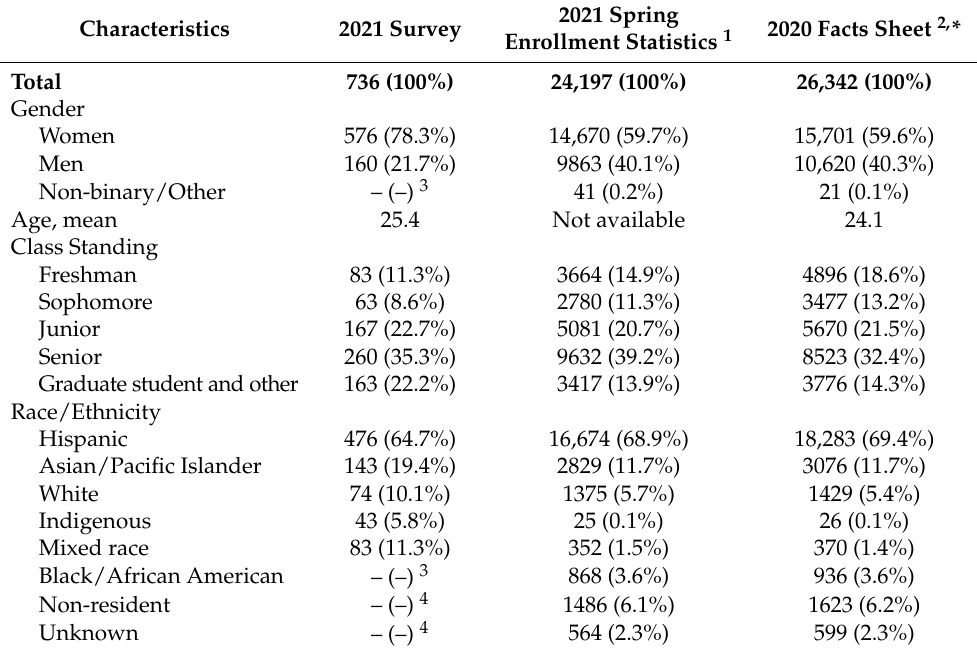
Table 1. Demographics of students at the California State University, Los Angeles from the 2021 Health During the COVID-19 Pandemic Student Survey , Cal State LA 2021 Spring Semester Enrollment Statistics, and the Cal State LA 2020 Facts Sheet